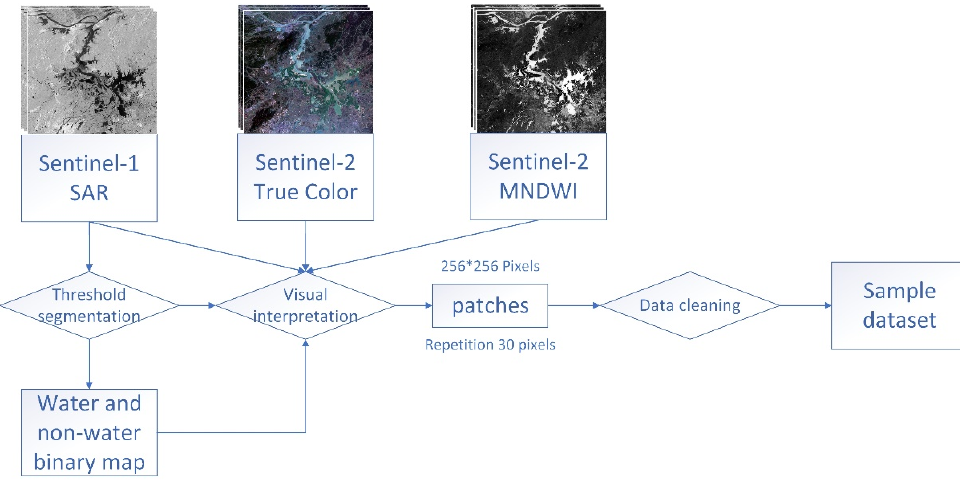
Figure 9 . Flowchart of the sample production process. Figure 9. Flowchart of the sample production